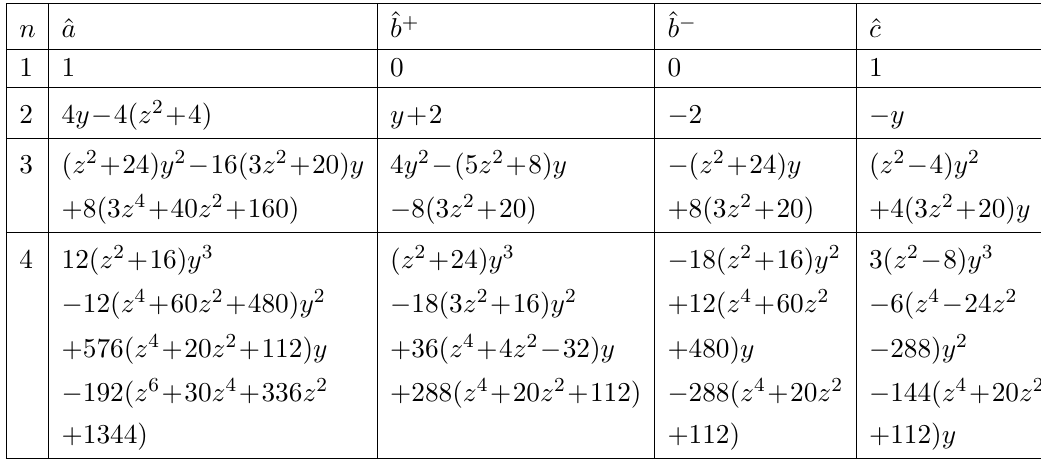
Table 3 . Table of the coefficients ˆ a n , ˆ b ± γ n y 3 , where γ n = 2 − (5 n +3) /